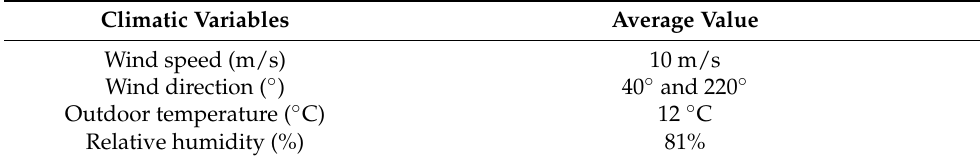
Table 3. Annual average values of climatic variables. Climatic